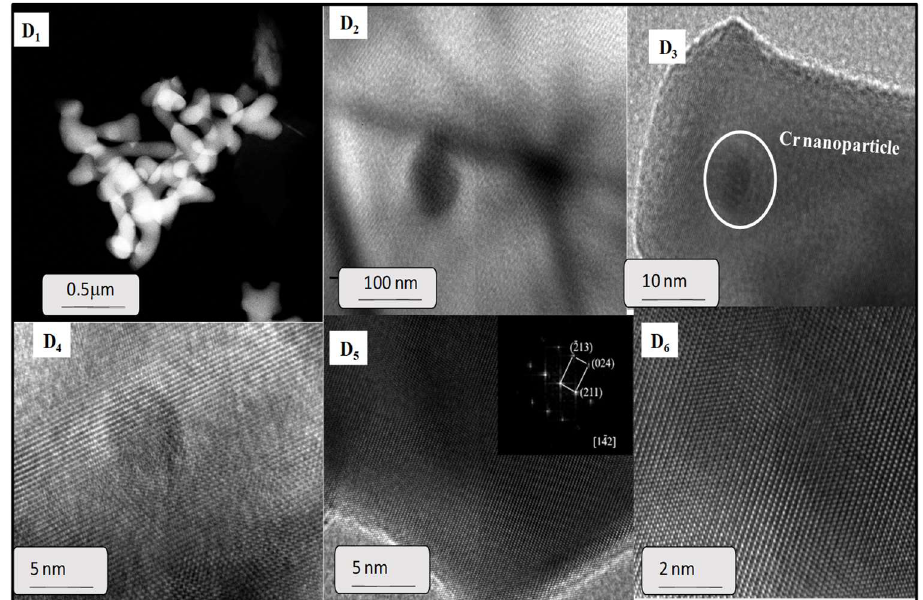
Figure 8. TEM images of the EC5YIG spent sample ( D 1 , D 2 , D 3 , D 4 , D 5 , D 6 ) after the catalytic test. The high magnification HRTEM images are accompanied with fast Fourier transform (FFT) where the crystal planes are shown to be in the (142) direction in the included ( D 5 ). Reaction conditions: EB to H 2 O 2 molar ratio of 1 using 1.3 mol of acetone as solvent, temperature of 50 °C and a catalyst mass of 50 mg within 360 min of reaction.